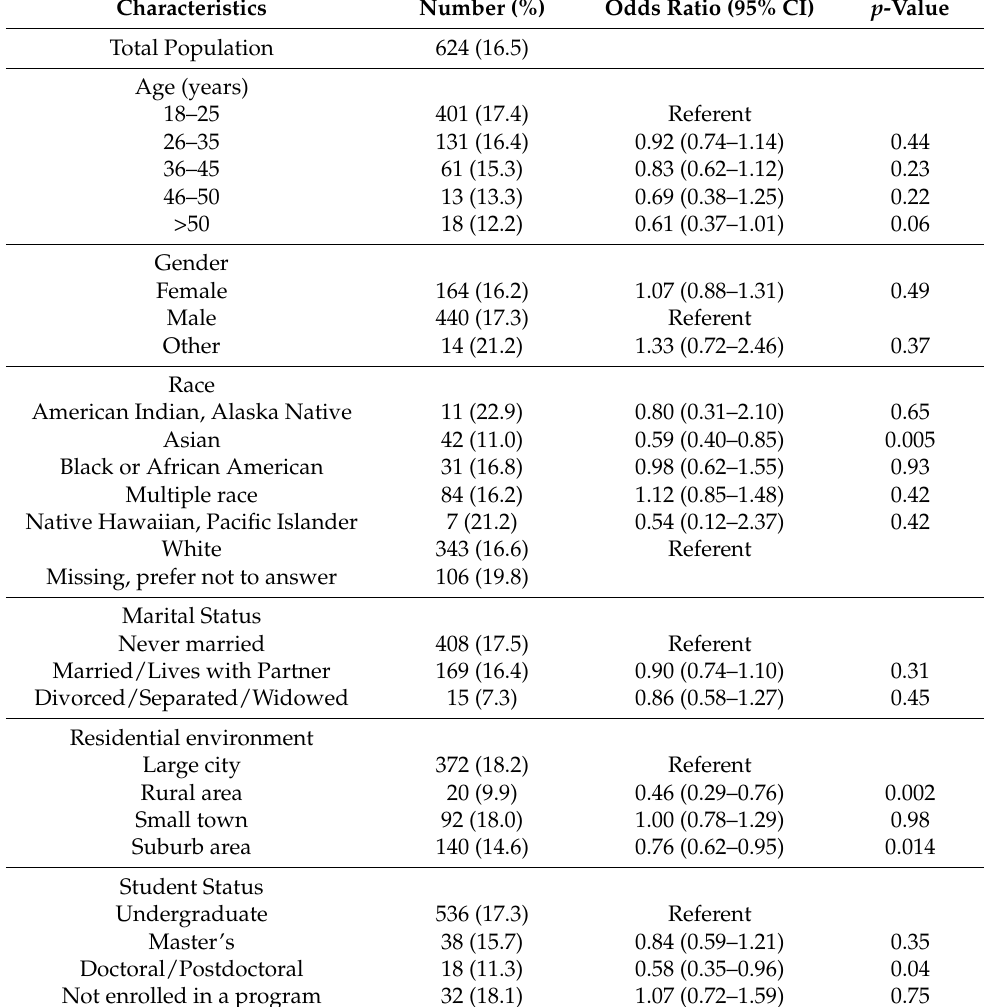
Table 2. COVID positive test results of respondents in the NSHE survey, February–March,